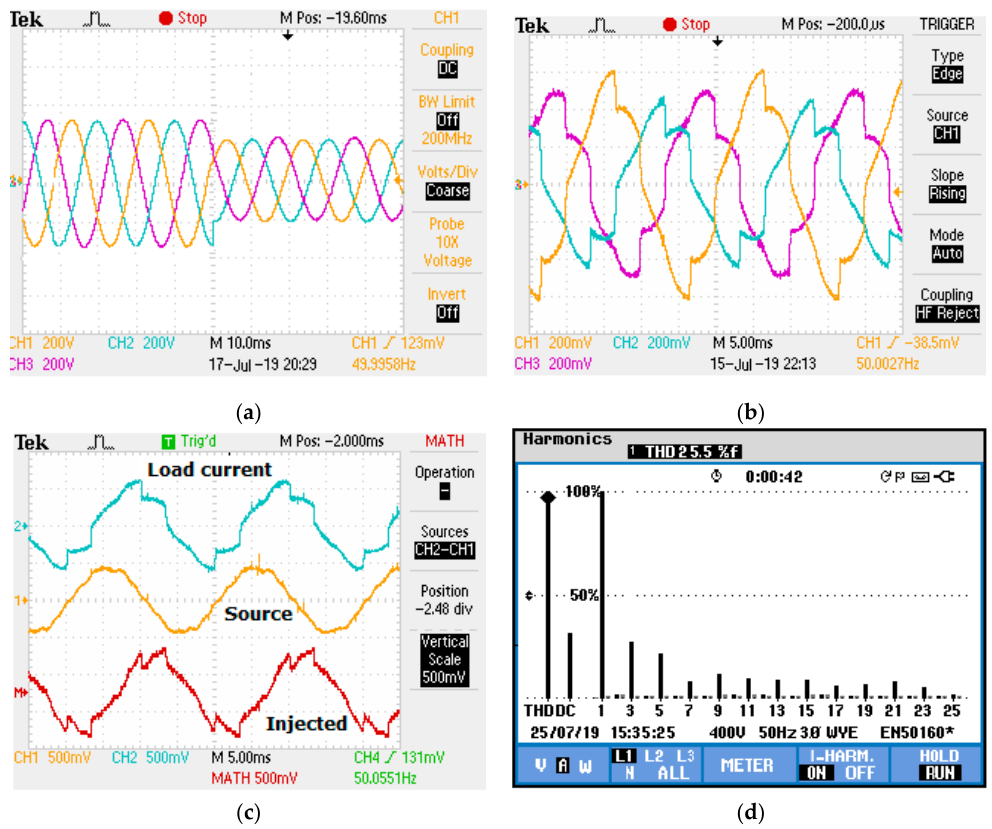
Figure 19. Experimental results under balanced voltages with unbalanced loads: ( a ) supply voltage; ( b ) load current; ( c ) load current, source current, and injected current; and ( d ) THD level of source current before connecting solar photovoltaic-supported QZSI-unified power quality conditioner in a phase-A.